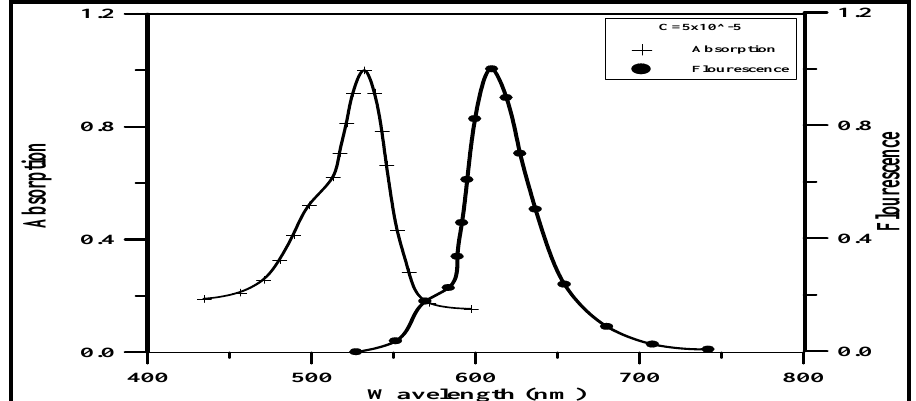
Fig.3: The absorption and fluorescence spectrum of R6G dye doped PMMA for concentration 5×10 -5 mol/ ℓ at thickness